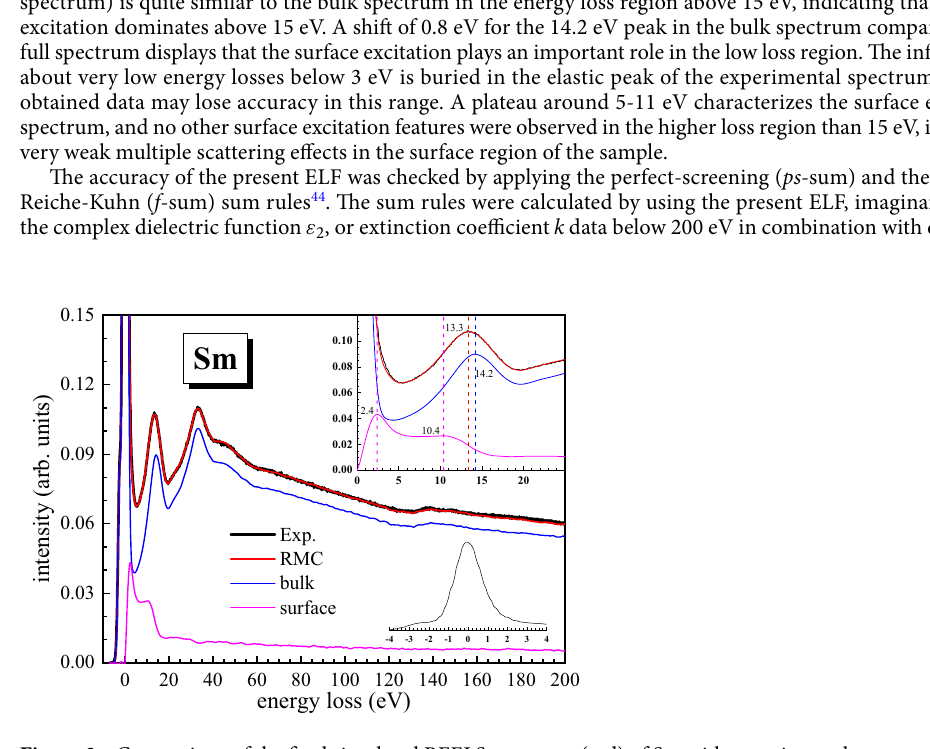
Figure 2. Comparison of the final simulated REELS spectrum (red) of Sm with experimental spectrum (black) for a primary electron beam of 2 keV. Pure bulk excitation component (blue) and surface excitation component (magenta) are also calculated based on the derived ELF by the Monte Carlo simulation. The upper inset shows the low loss region, and the lower inset illustrates the energy distribution of the elastic